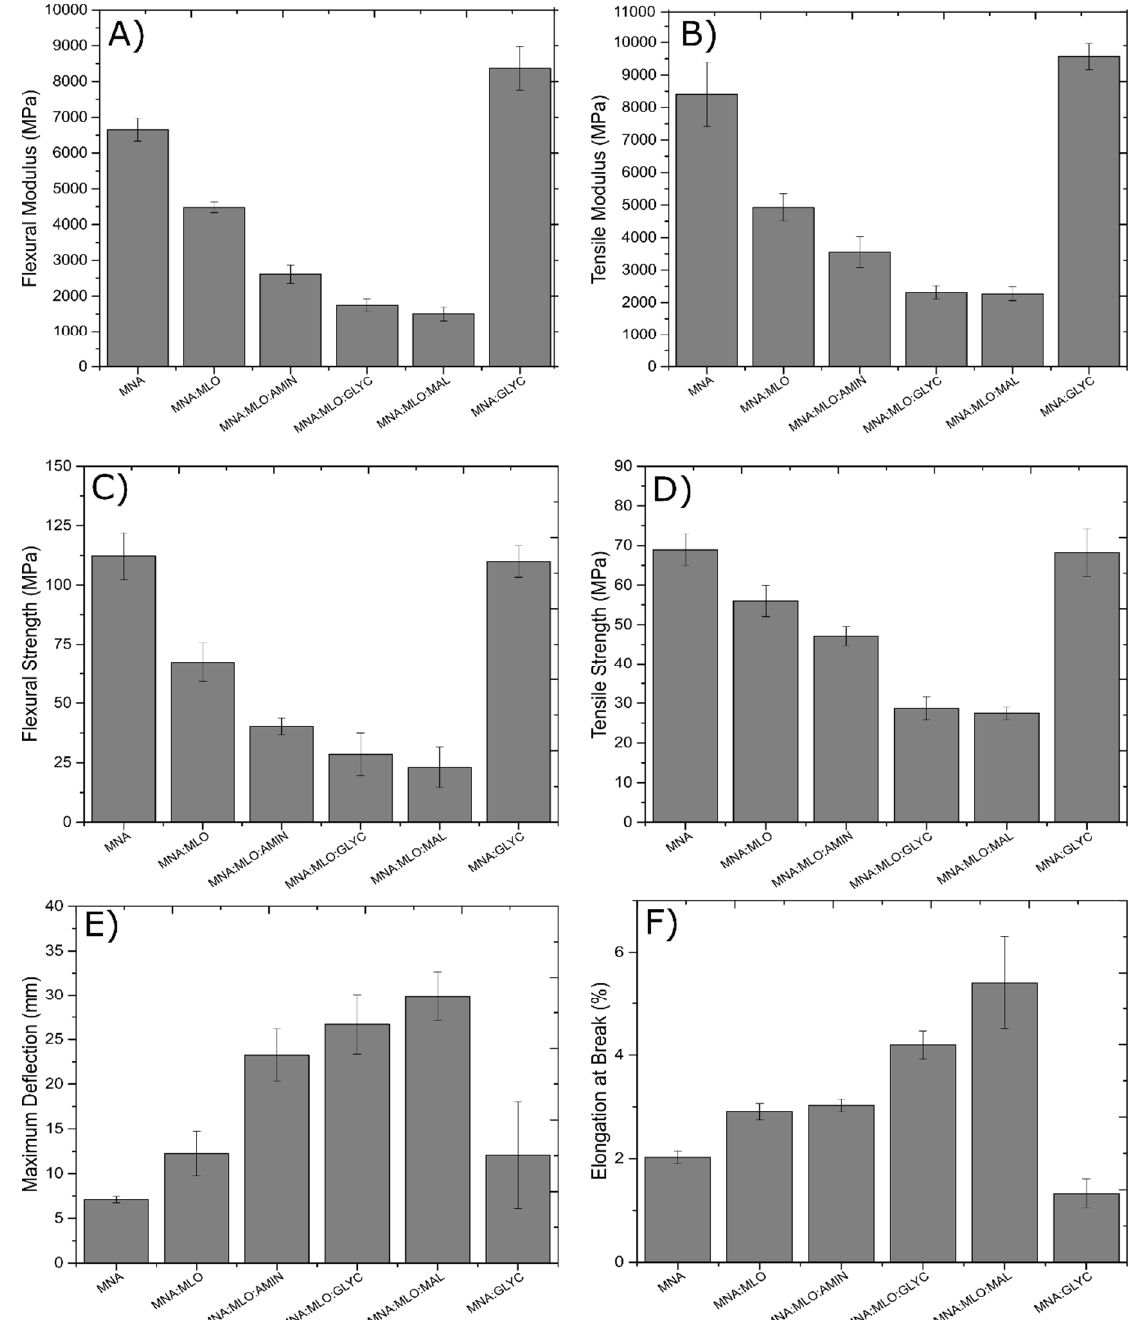
Figure 3. Comparative bar plot of the flexural and tensile properties of composites based on ELO epoxy resin cross-linked with MNA/MLO mixture and flax fabric reinforcement with different surface treatments: ( A ) flexural modulus, ( B ) tensile modulus, ( C ) flexural strength, ( D ) tensile strength, ( E ) maximum flexural deflection, and ( F ) % elongation at break.